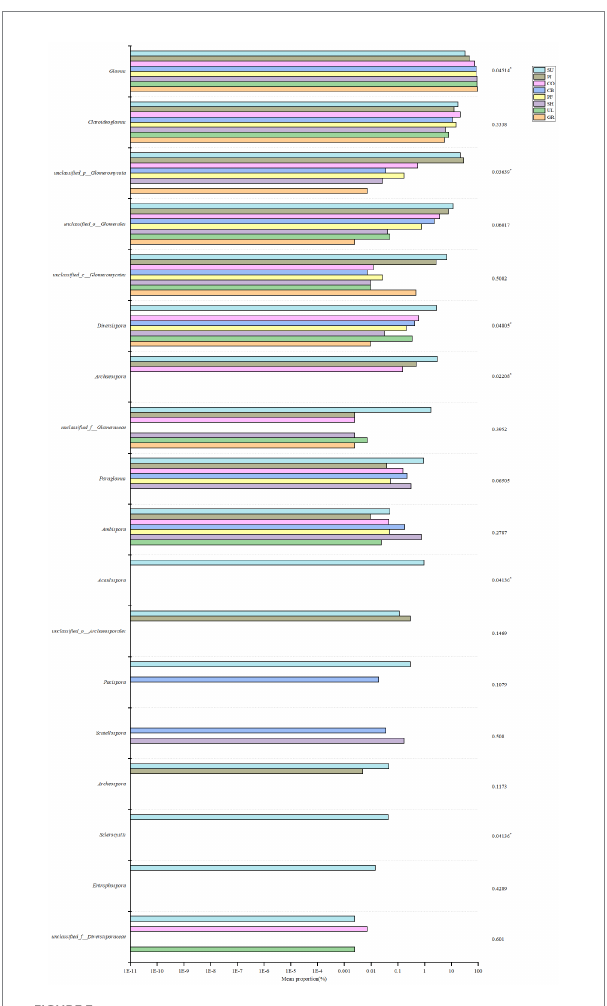
FIGURE 3 Significance test for differences in AMF species at different altitudes. *represent significant correlations at the 0.05, **represent significant correlations at the 0.01, and ***represent significant correlations at the 0.001.